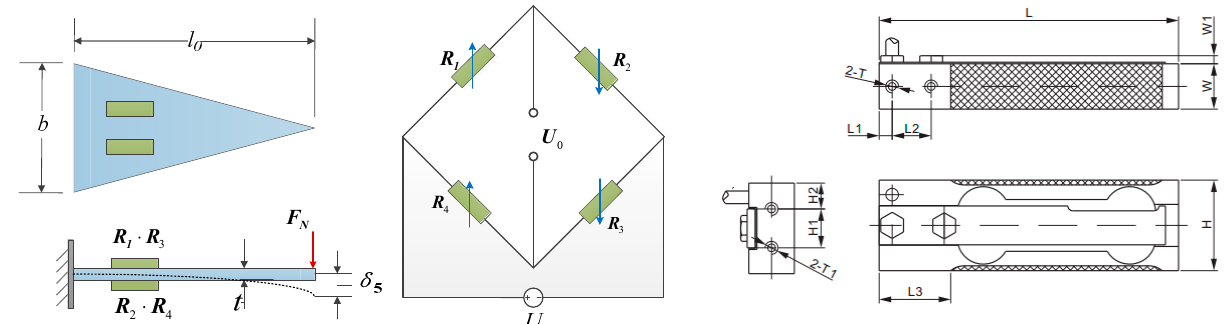
Figure 3. Structure of the resistance strain gauge type load cell.